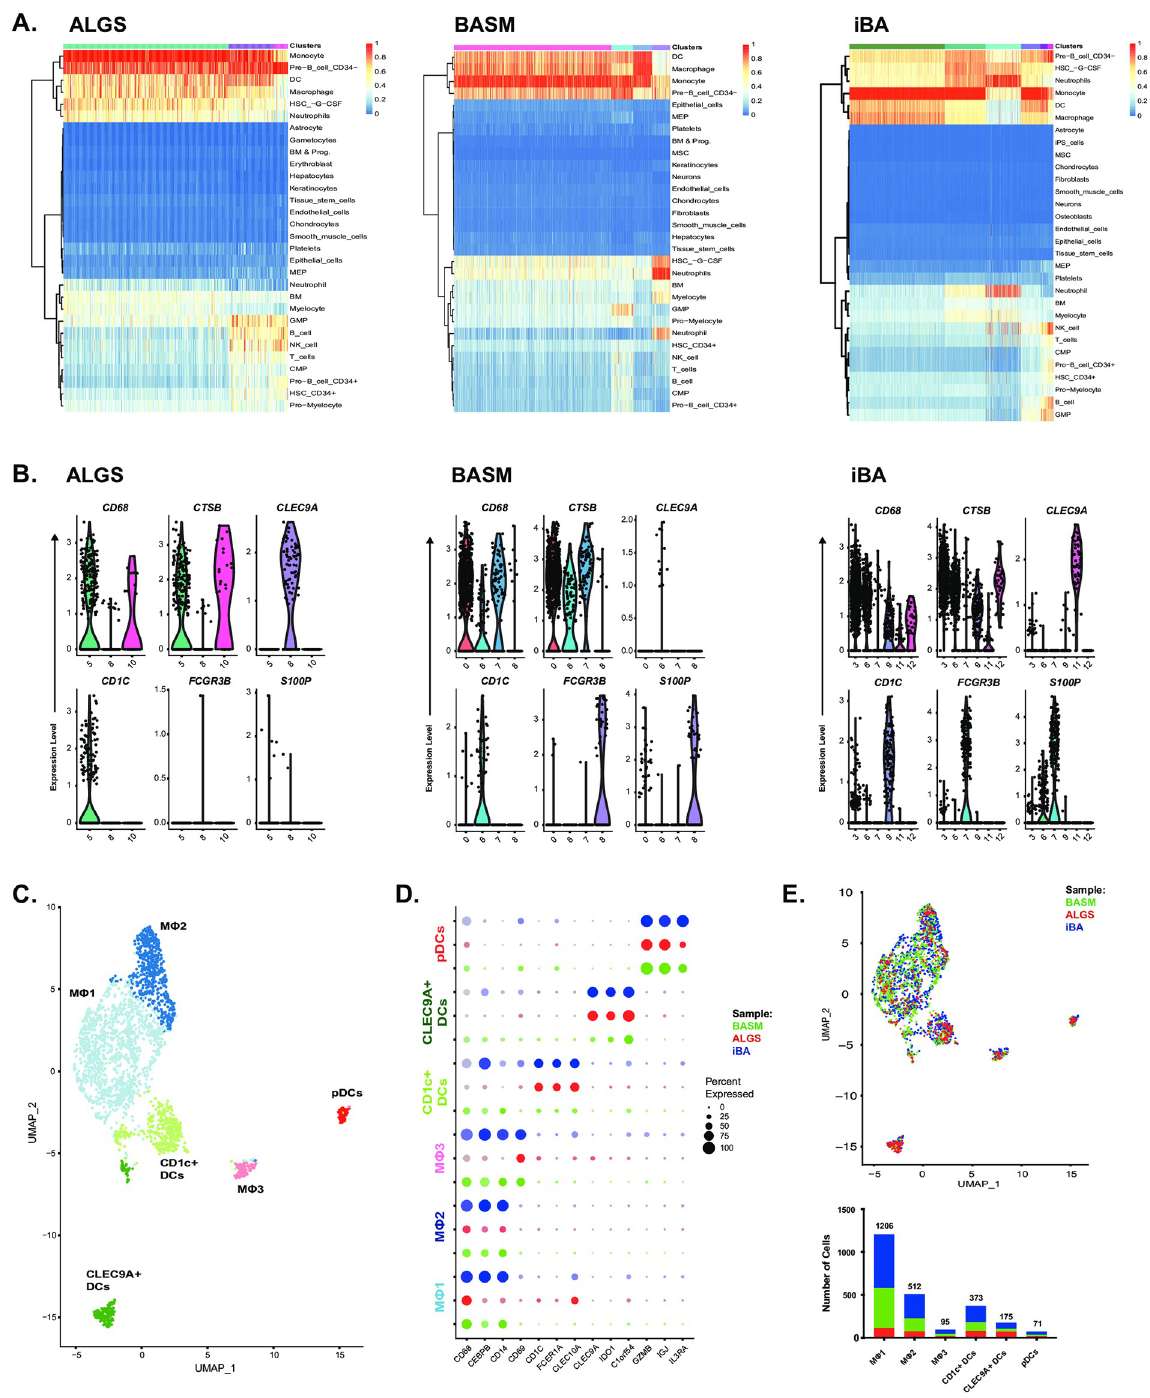
Fig 3. Integrated analysis of myeloid cells across patients identifies 3 distinct macrophage subsets in cholestasis. Comparison of annotated ALGS (5, 8, and 10, left), BASM (0, 6, 7, and 8, middle) and iBA (3, 6, 7, 9, 11, and 12, right) myeloid cell clusters with reference data set identified neutrophil clusters in BASM (8) and iBA (7) (A). While all other clusters expressed macrophage and/or dendritic cell markers, BASM cluster 8 and iBA cluster 7 expressed neutrophil markers FCGR3B and S100P (B). UMAP of remaining MNP cells showed 6 integrated clusters (C). Expression of key markers enabled identification of CD1c+ DCs (light green), CLEC9A+ DCs (dark green), pDCs (red), and 3 macrophage subsets (light blue, dark blue, and pink) across ALGS (red), BASM (green), and iBA (blue) patients (D). BASM (green) and iBA (blue) cells represented the majority in the macrophage clusters